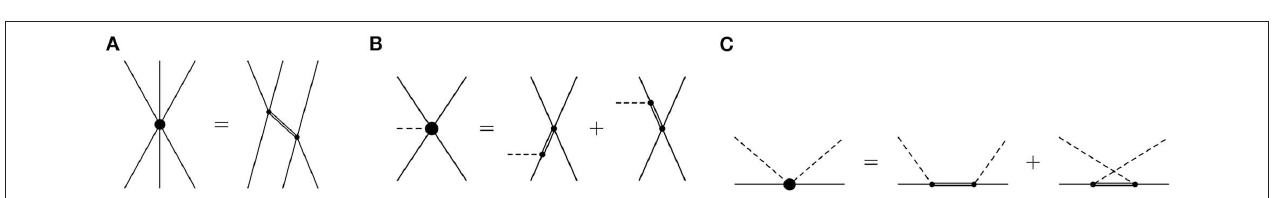
BB φ vertex. (C) Saturation of the →